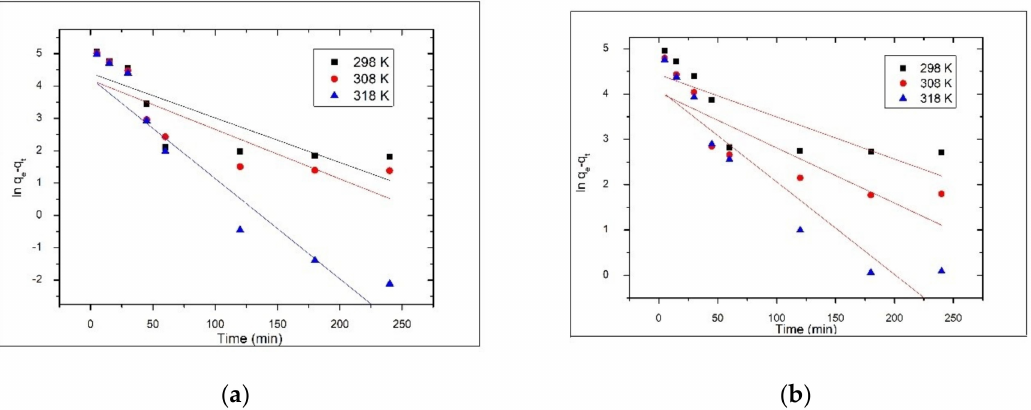
Figure 7. Pseudo-first-order kinetic model for As(V) adsorption onto functionalized materials ( a ) V-DEHPA-Fe and ( b ) VF-DEHPA-Fe, at different